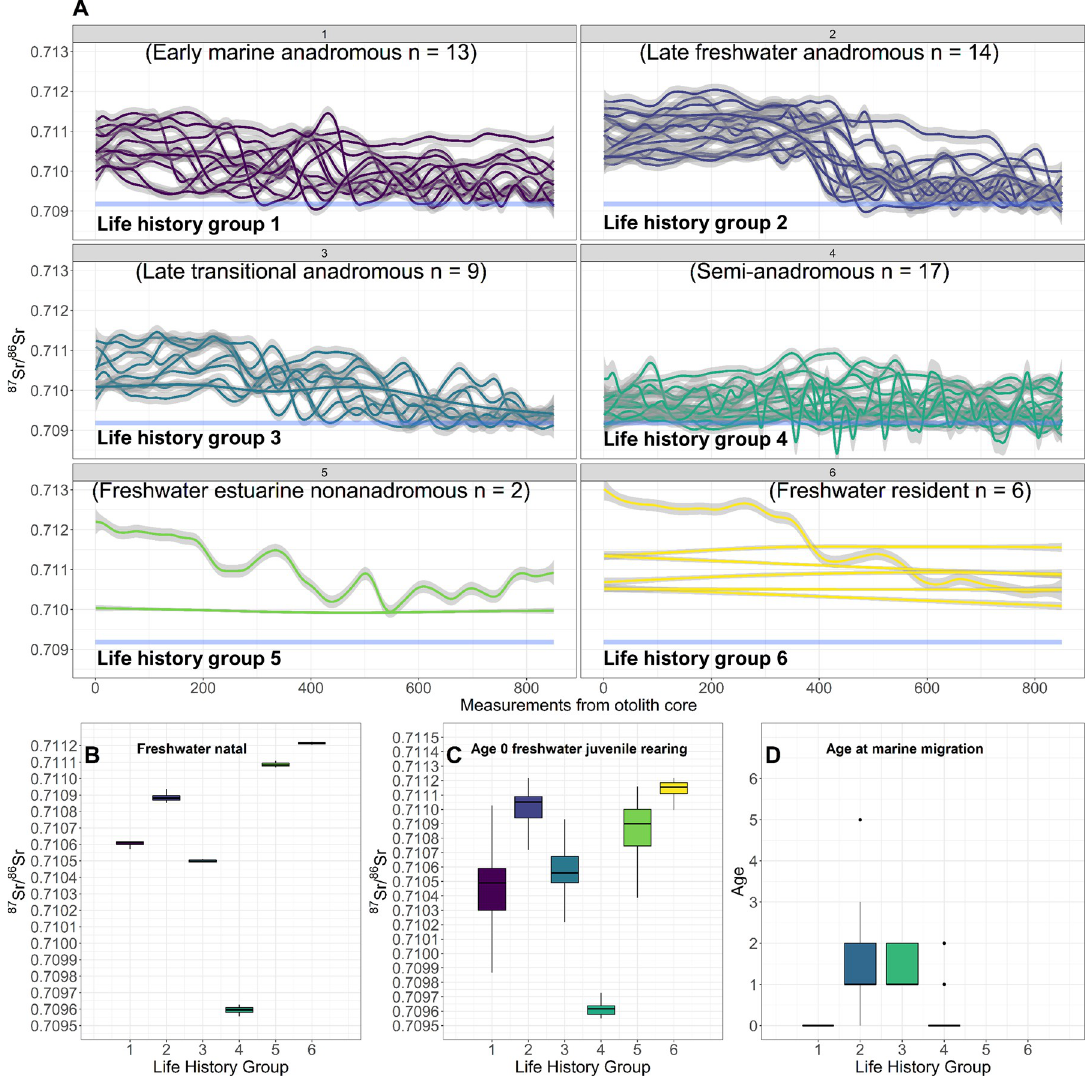
Fig 3. Otolith life history classification. Classification of 61 Broad Whitefish ( Coregonus nasus ) from the Colville River, AK, USA into six life history types based on strategy (anadromous, semi-anadromous, nonanadromous), rearing habitat used (marine, brackish, freshwater), and age at marine migration. Anadromous individuals (Types 1–3), semi-anadromous (Type 4), and non-anadromous (Types 5–6) are individually colored by life history type. Fitted Generalized Additive Model values of the first 850 raw 87 Sr/ 86 Sr (solid- colored lines) and 95% confidence interval (grey shading) for each individual and life history type are shown in panel (A). The horizontal light blue line represents the global mean oceanic value (GMV = 0.70918 ± 0.00006 2 SD). Panel (B) and (C) show boxplots of the freshwater natal region and the freshwater juvenile rearing region. Panel (D) shows boxplots for the age of first marine migration for each life history group. Each boxplot shows the median value ( 87 Sr/ 86 Sr value or age) for each life history type (horizontal black line), IQR (box outline), the maximum value within 1.5 times the IQR (vertical black line), and outside values greater than 1.5 times the IQR (black dots). late transitional) had similar values with mean natal region 87 Sr/ 86 Sr ranging from 0.71052 to 0.71083 (Table 3). Individuals with the semi-anadromous life history type had natal region 87 Sr/ 86 Sr centered at 0.70961 and were the lowest values observed (Table 3). Nonanadromous individuals (freshwater estuarine, freshwater resident) had mean natal region 87 Sr/ 86 Sr ranging from 0.71106 to 0.71122 and were the highest values observed (Table 3).